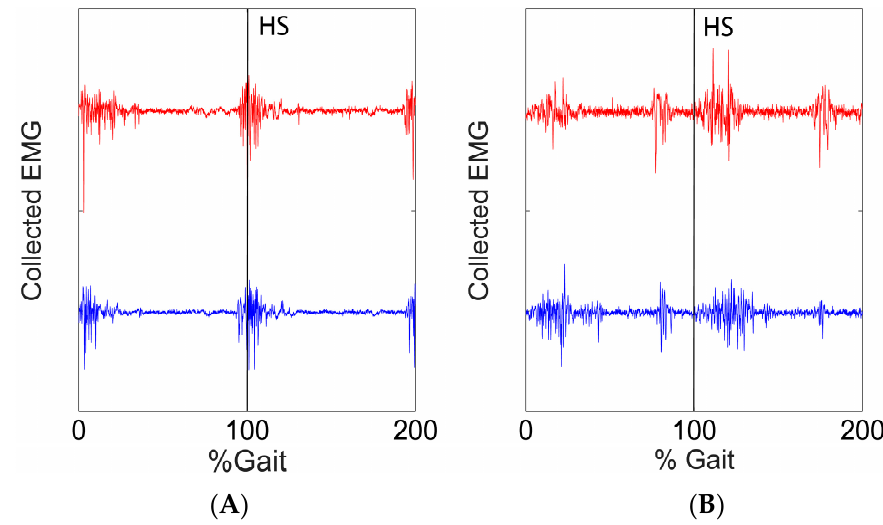
Figure 9 . Comparison of raw EMG signals from two channels (Channel ( A ) BFL and Channel ( B ) RF) at the training session and at the final test session (adaptive #10). The EMG signals were collected in two gait cycles at level ground walking. The red line showed the EMG at the training session and the blue line showed the EMG at the final test sessions. The vertical lines indicated heel strike (HS).